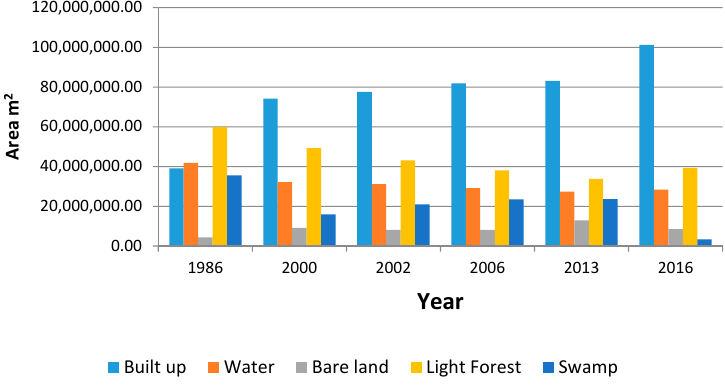
Figure 2. Land use/Land Cover between 1986 and